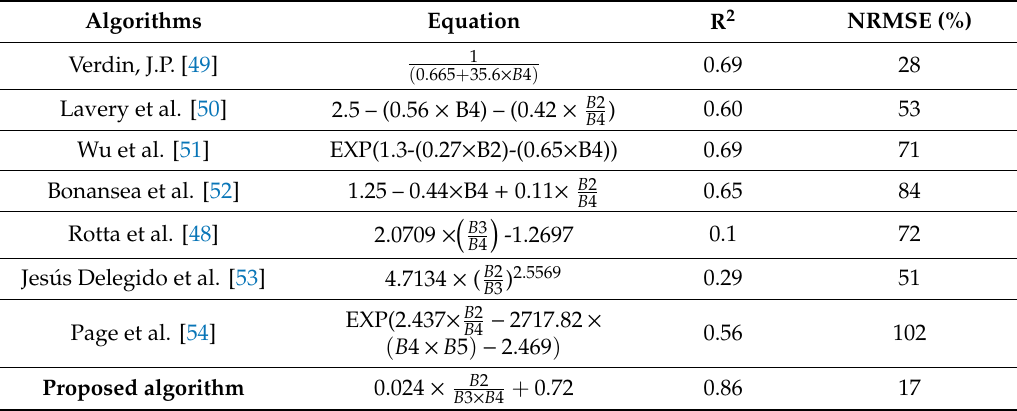
Table 5. Statistical parameters obtained for the application of Secchi Depth algorithms from the literature and that proposed in this study, to the Alqueva reservoir.